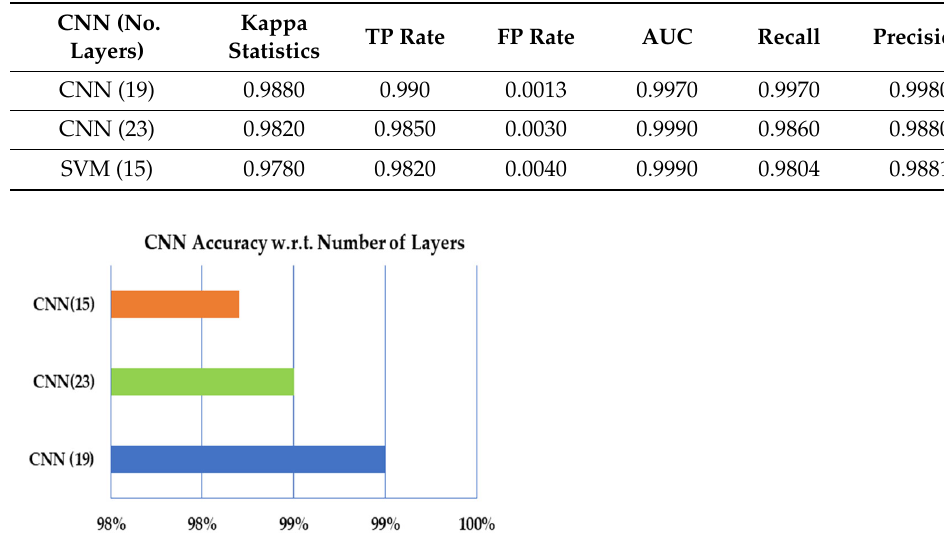
Table 7. Overall accuracy of CNN with respect to training and testing ratios.